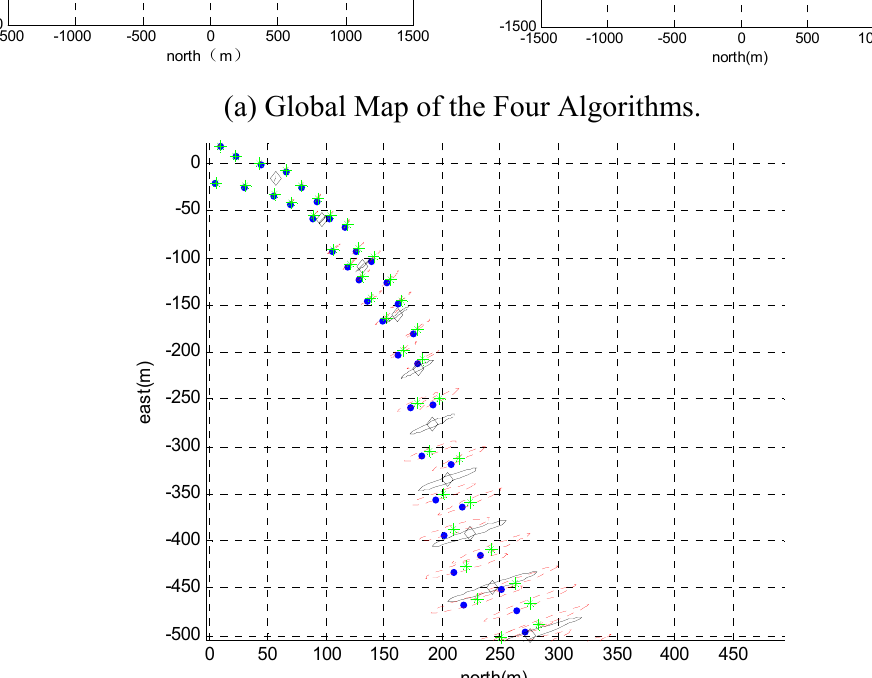
(b) Zoomed First Ten Submaps of